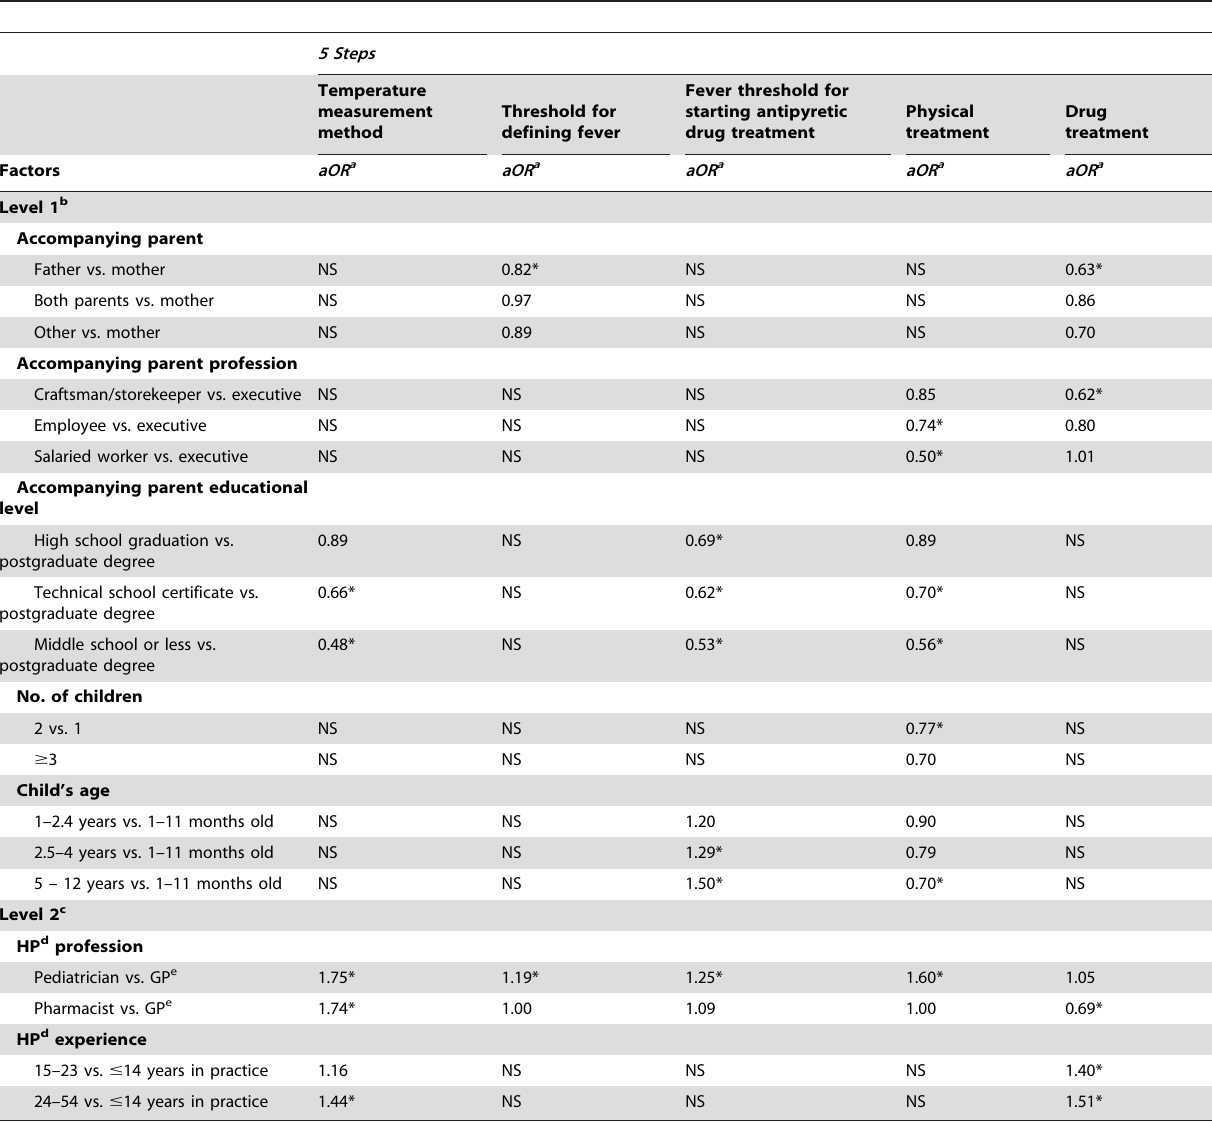
Table 2. Summary of actors associated with high concordance with recommendations for the 5 key steps in managing fever symptoms in children (see details including confidence intervals in appendix 2 to